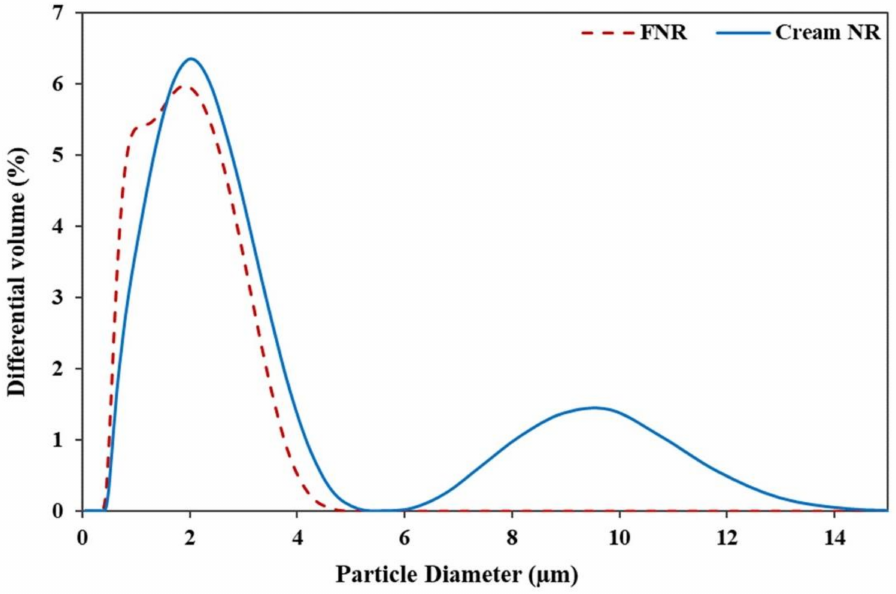
Figure 8. Particle size distribution of the fresh natural latex and cream concentrated latex from the RRIM600 clone.